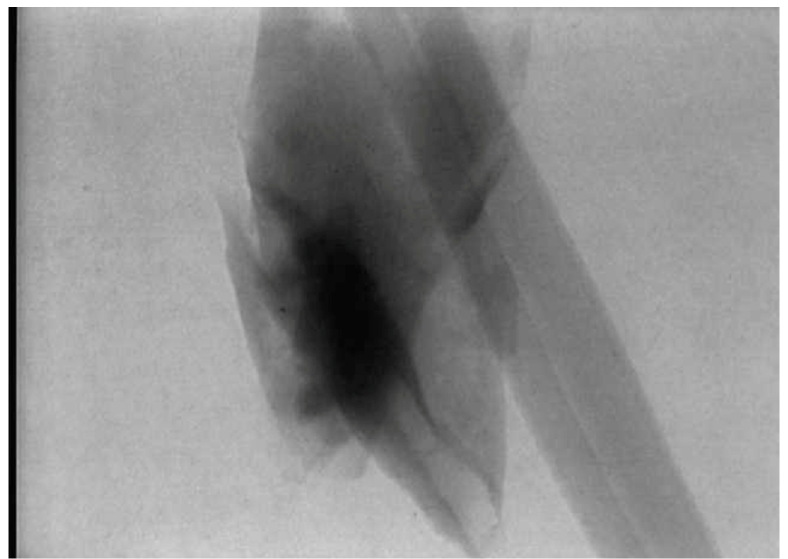
Figure 15. TEM micrograph of Cloisite 20A clay at ×600,000 for a single clay crystal on a lacey carbon showing sharp edges.